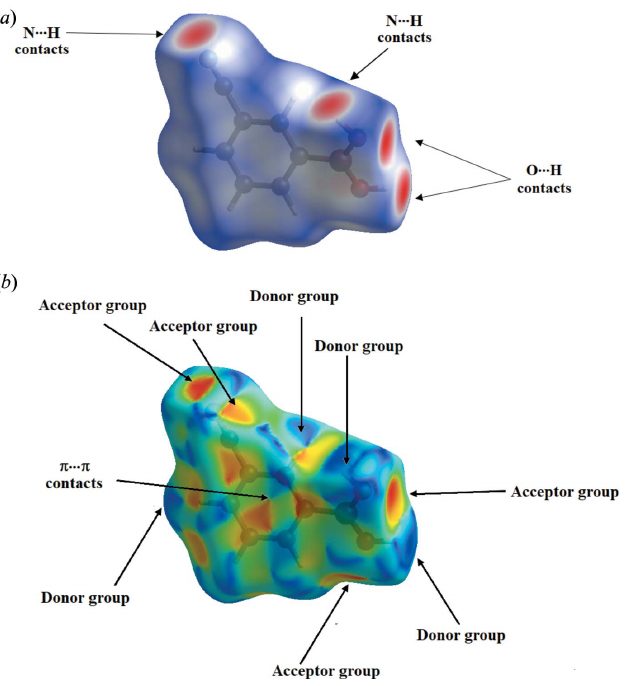
Figure 5 Two-dimensional fingerprints of compound (I), showing H (cid:3)(cid:3)(cid:3) H, N (cid:3)(cid:3)(cid:3)